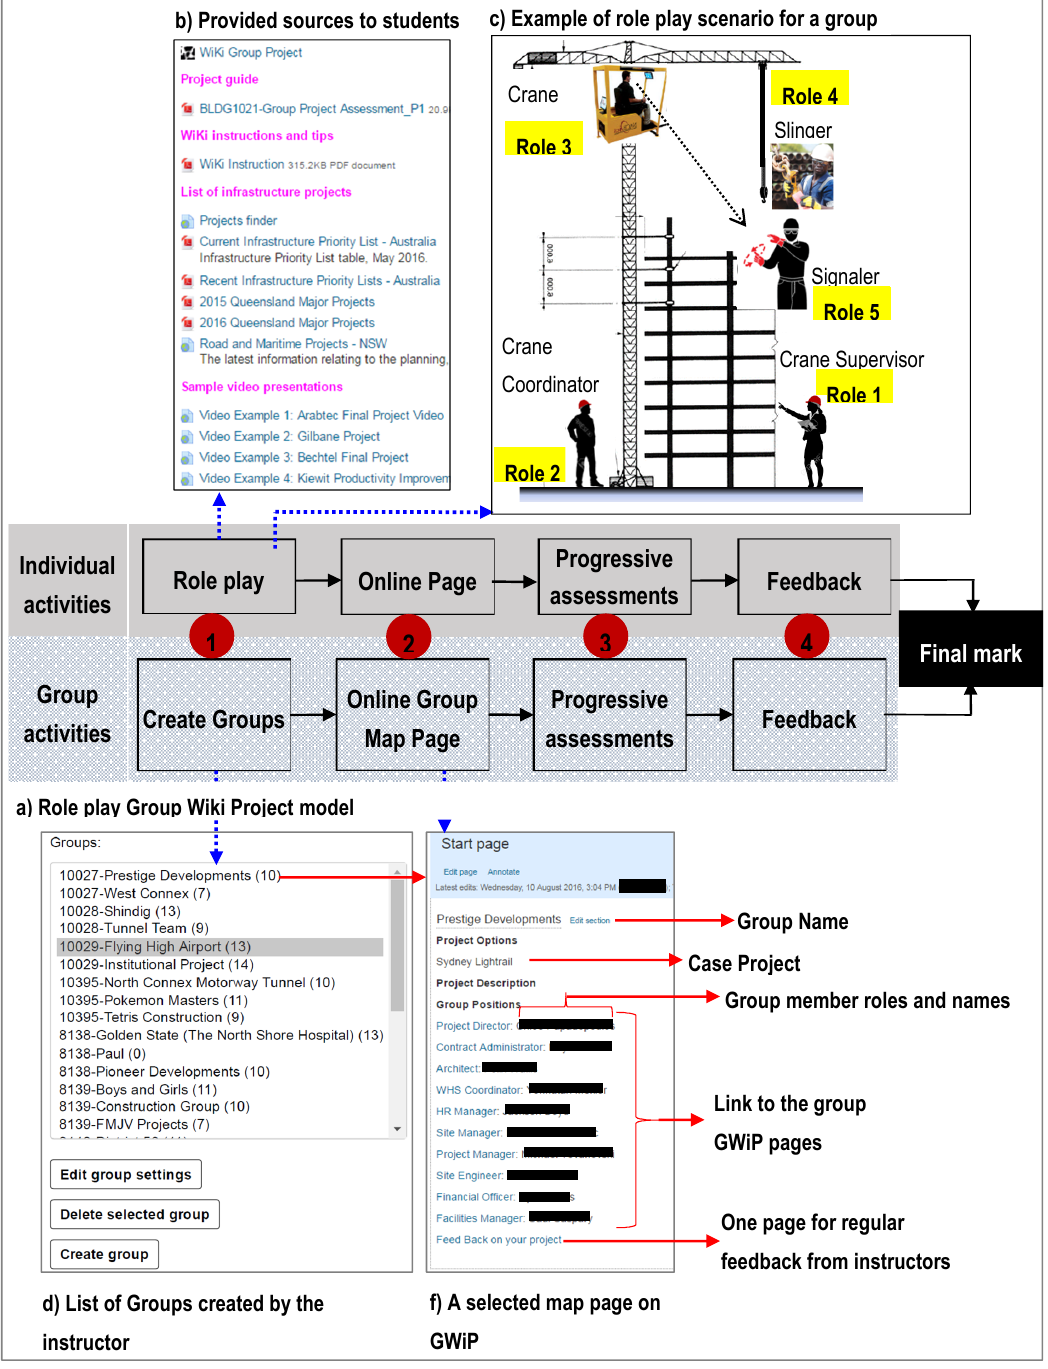
Figure 3. Role playgroup project model and list of groups and examples on GWiP. ( a ) Role play Group Wiki Project model; ( b ) Provided sources to students; ( c ) Example of role play scenario for a group; ( d ) List of Groups created by the instructor; ( f ) A selected map page on